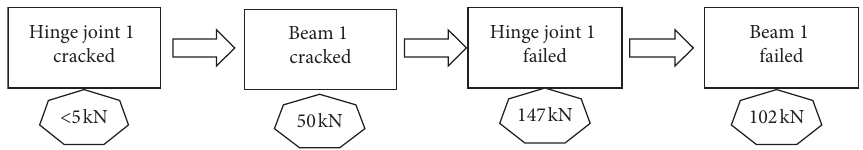
Figure 10: The failure sequence of model bridge in Load Case 1 and Load Case